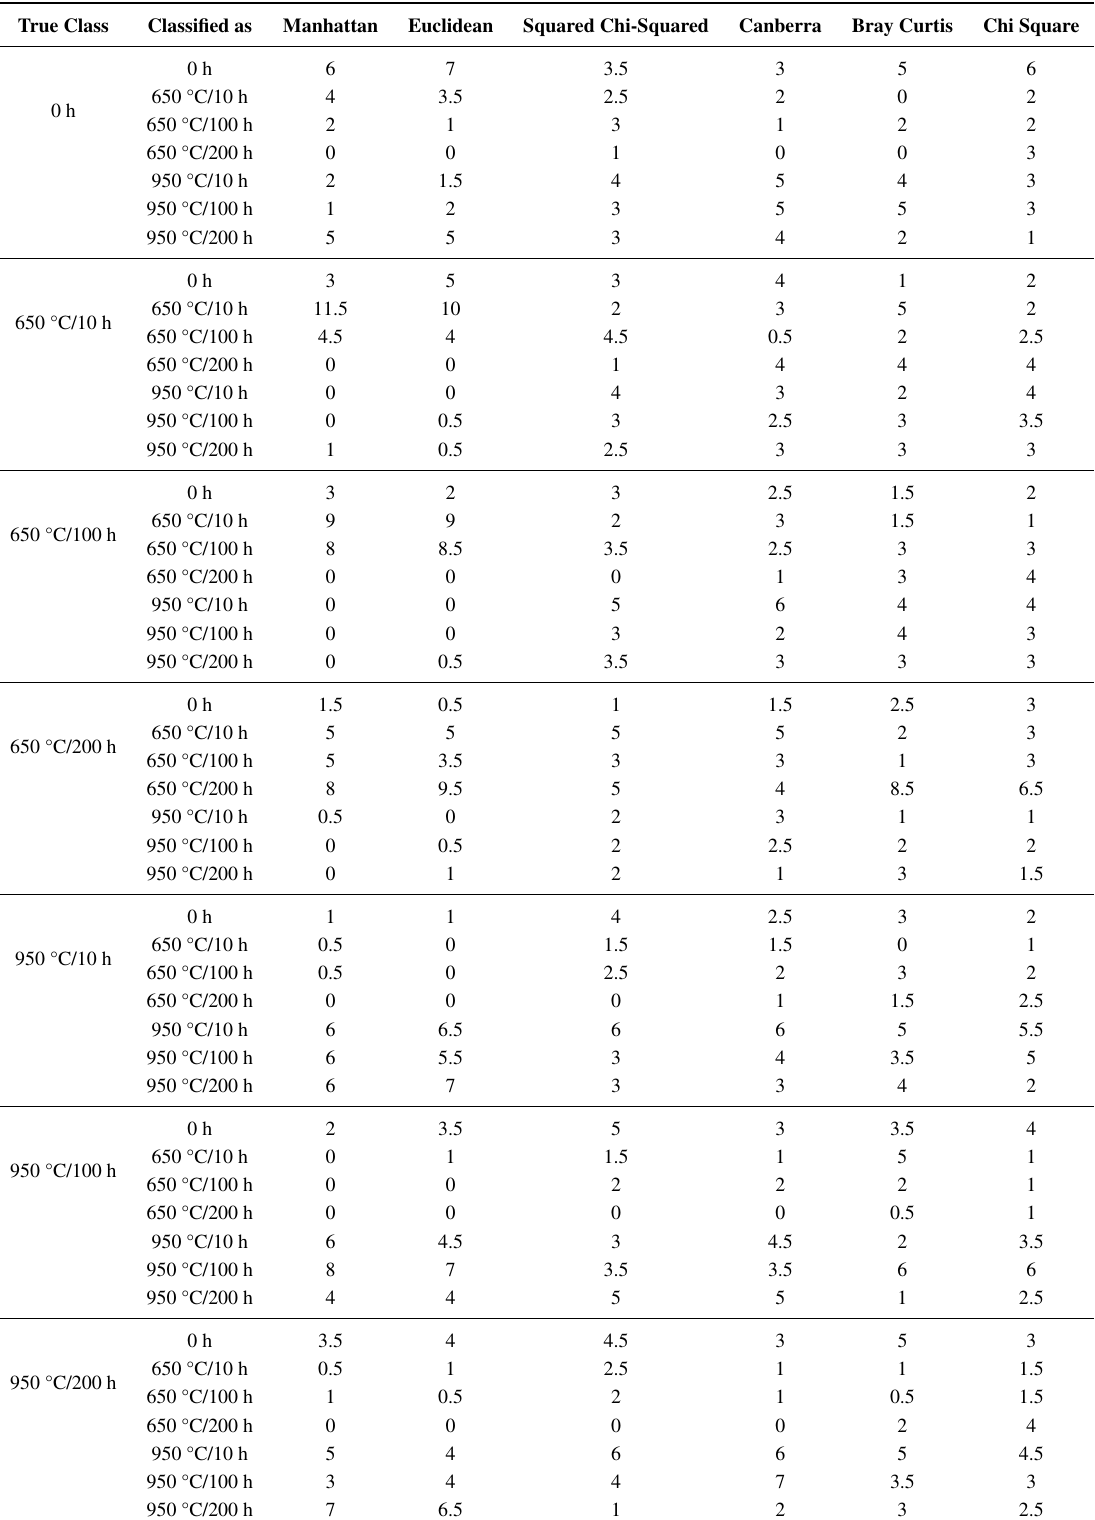
Table 17. Confusion matrix of the classification means for the 5-MHz frequency backscattered signals at 650 and 950